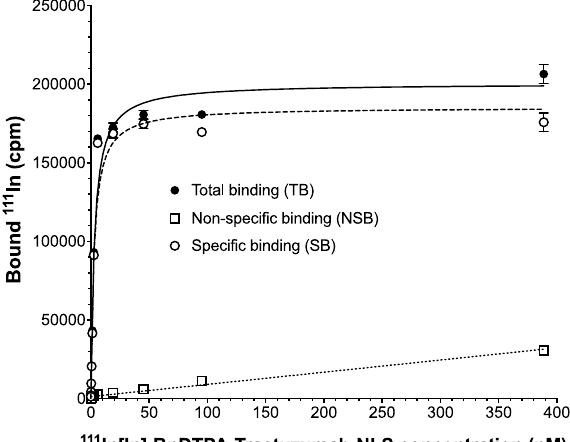
Fig. 4 Representative direct (saturation) receptor-binding curve for the binding of 111 In[In]-BnDTPA-trastu zumab-NLS prepared from kit Lot 18N008 to HER2-positive SK-BR-3 human breast cancer (BC) cells. Shown are the total binding (TB) and non-specific binding (NSB) in the presence of an excess (15.2 μmoles/L) of trastuzumab. The specific binding (SB) was calculated by subtracting NSB from TB. In this representative HER2 binding assay, the K a was 3.8 0.6 10 8 L/mole and the B max was 1.0 0.03 10 6 sites per ± × ± ×